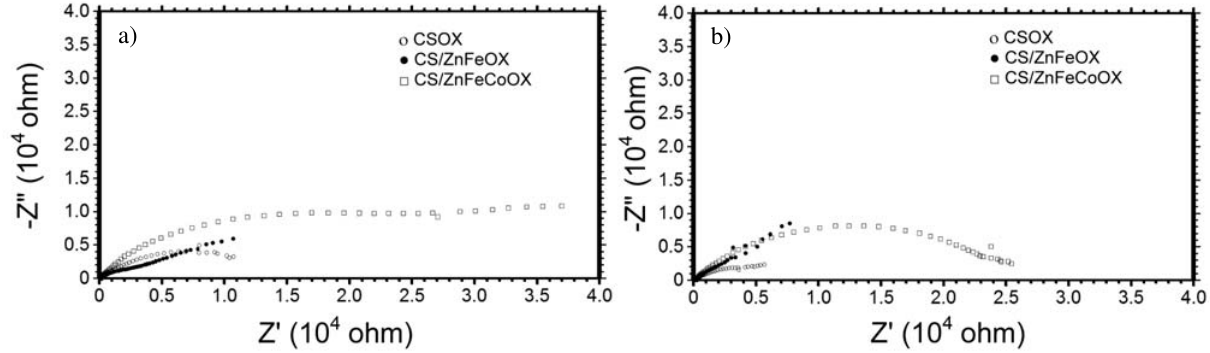
Fig. 7. The Nyquist curves of electrodes after (a) 48 h and (b) 168 h of exposure time in 3.5% NaCl solution.